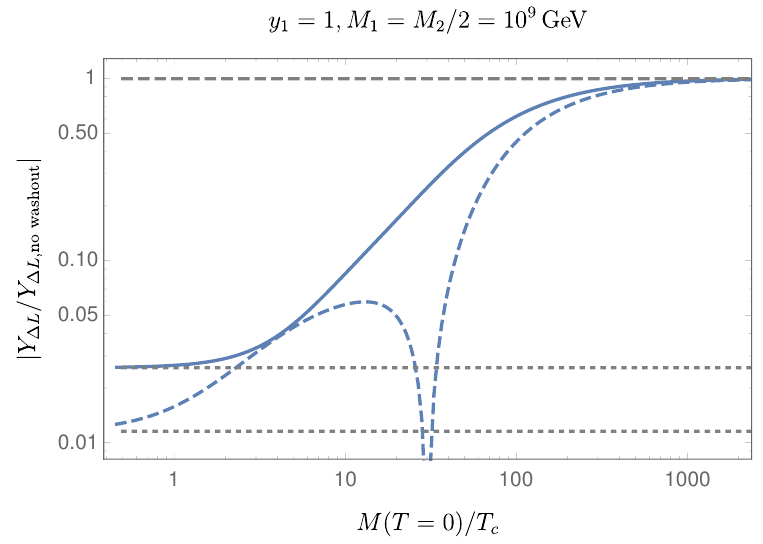
Figure 2 . Dependence of the asymmetry on the critical temperature of a second-order phase transition giving rise to RHN masses, eq. (3.26). Results are shown in the tree-level approximation with leading temperature corrections. The dashed-gray and dotted-gray lines show the asymptotic results expected for zero washout and constant masses, respectively. We set y 1 = 1, M 1 = M 2 = 2 = 10 9 GeV, and calculate the asymmetry for two choices of Yukawa matrix F compatible with global (cid:12)ts to oscillation measurements, given by eqs. (E.3) and (E.4) in appendix E. For the solid blue line, the sign of the asymmetry for constant M I does not change in the limit of zero washout, as opposed to the case of the dashed blue line, for which (cid:13)avour e(cid:11)ects change the sign of the